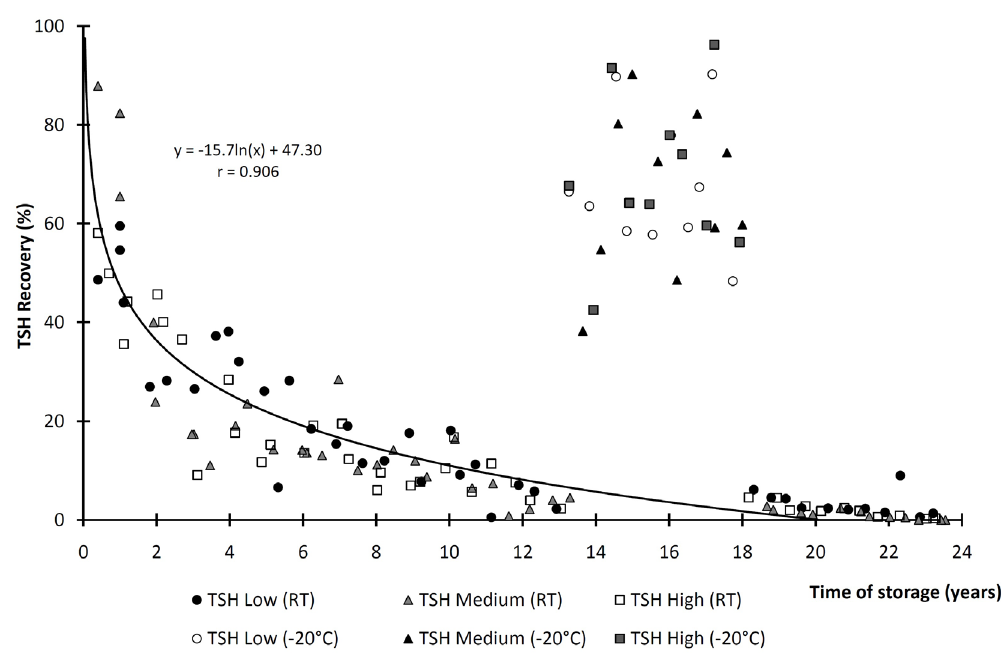
Figure 3. TSH recovery at retesting in residual DBS specimens stored in two different storage conditions. RT: room temperature.